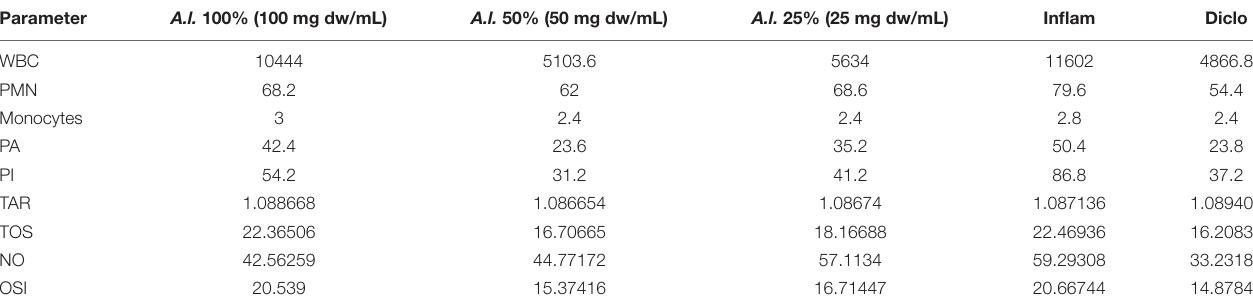
TABLE 9 | Anti-inflammatory activity of A. laxmannii extracts (WBC, PMN, Monocytes, PA, PI, TAR, TOS, NO, OSI).